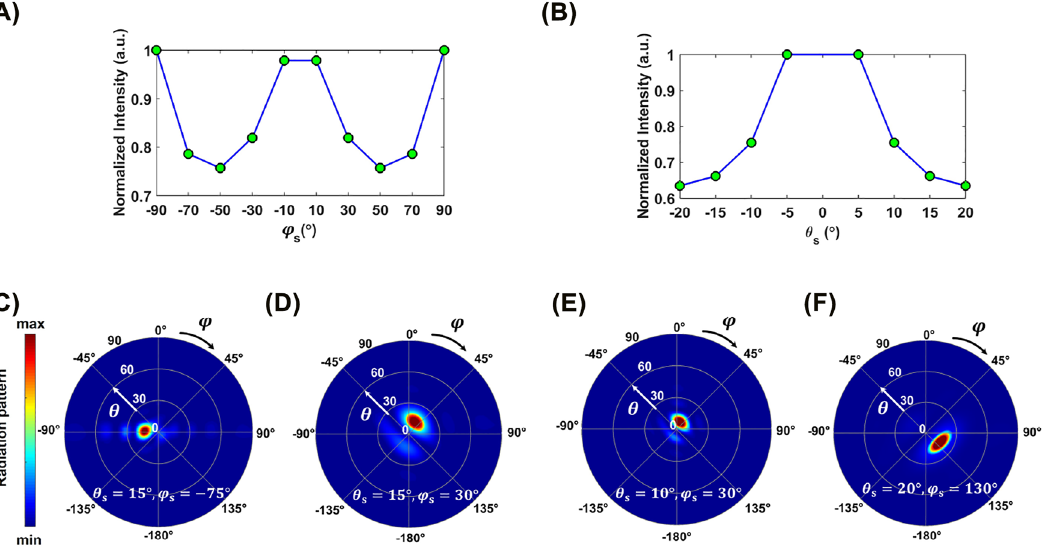
= 15 ◦ and (B) 𝜃 , when 𝜃 s s = 15 ◦ ,𝜑 = 30 ◦ ), (E) ( 𝜃 s s